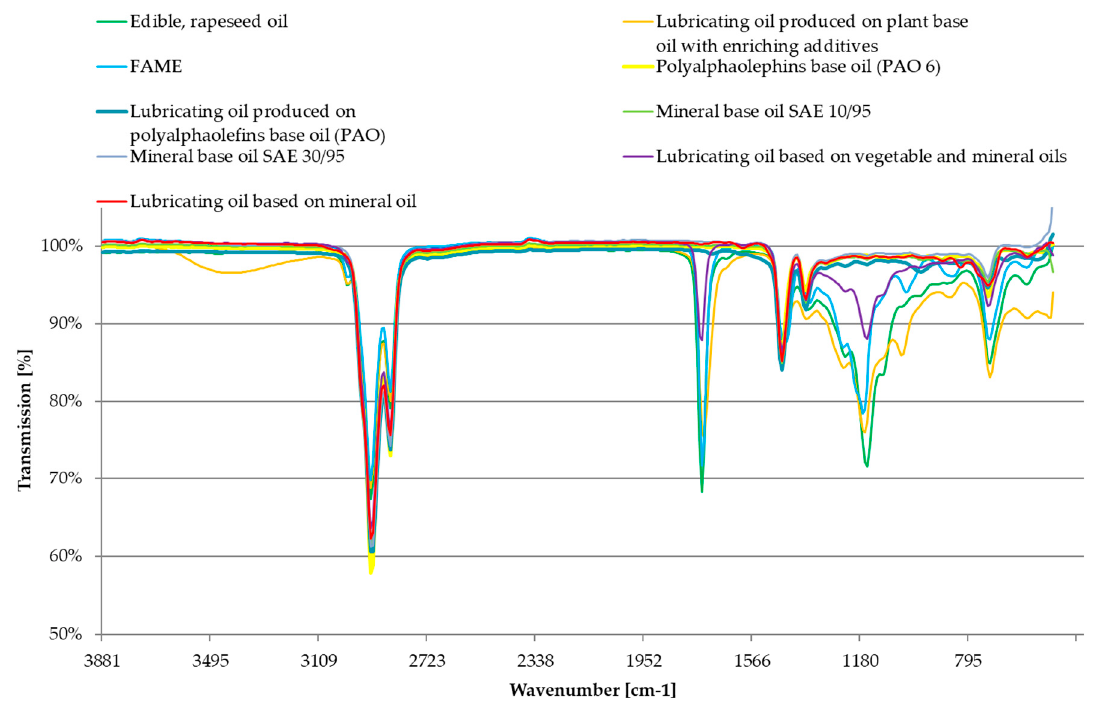
Figure 5. Compilation of FT-MIR spectra for tested oil samples.